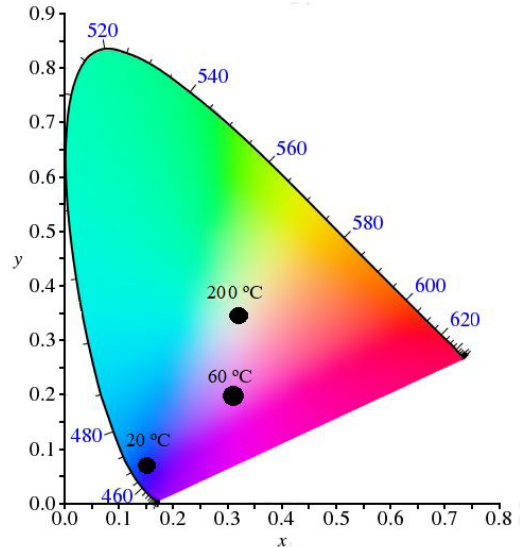
Figure 10. CIE chromaticity diagram showing the color emission of CoHo:PGLyD microspheres at 20 ºC, 60 ºC and 200 ºC, respectively.